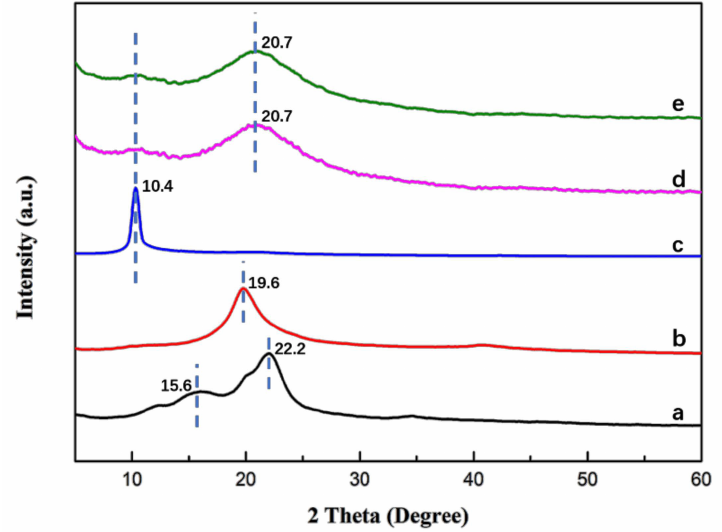
Figure 5. XRDpatternsof( a )CNFs,( b )PVA,( c )GO,( d )CNF / PVA / GOand( e )TMCS / CNF / PVA /